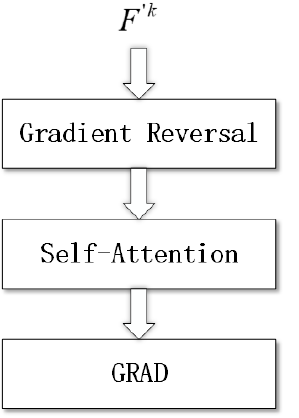
Figure 4. Generalized resource adversarial discriminator.